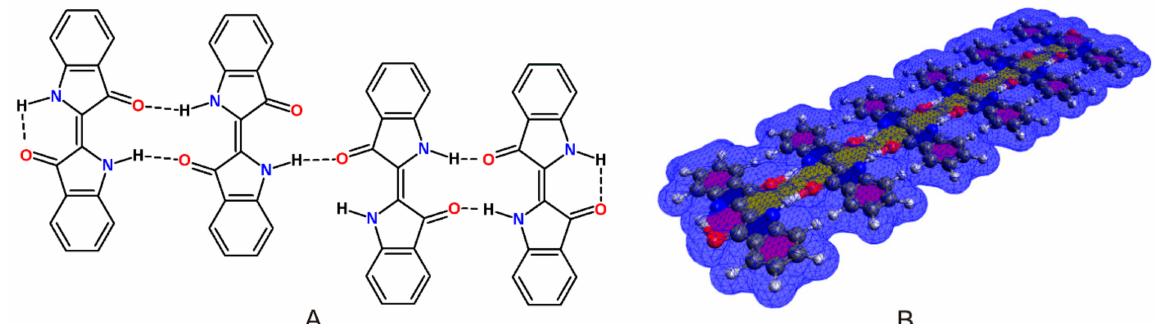
Figure 2. ( A ): E-indigo cluster with intra- and intermolecular hydrogen bonds and the effect of different 2D chirality on the self-assembly. Carbonyl and amino groups without planar hydrogen bonds can form a bond to an upper or a lower layer. ( B ): E-indigo molecules forming a platelet with intermolecular hydrogen bonds (green). The surface is characterized by delocalized electrons in π